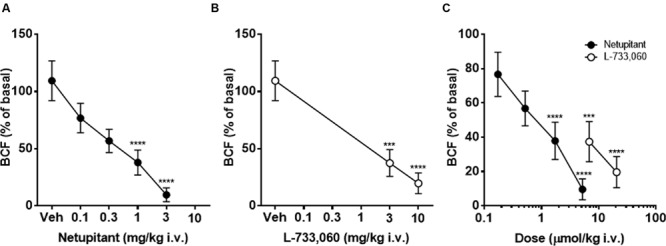
Cystometry under isovolumetric conditions in female guinea-pigs. Graph showing the effects of graded doses of netupitant (A) (n = 10 for each dose) and L-733,060 (B) (n = 10 for each dose) on bladder contraction frequency (BCF). Doses of netupitant and L-733,060 are expressed in μmol/kg to compare the potencies of these drugs on BCF (C). Asterisks indicate statistical difference from the basal (∗∗∗P < 0.001, ∗∗∗∗P < 0.0001, Sidak’s multiple comparison test following repeated measures two-way ANOVA). All statistical analyses were performed using actual values.